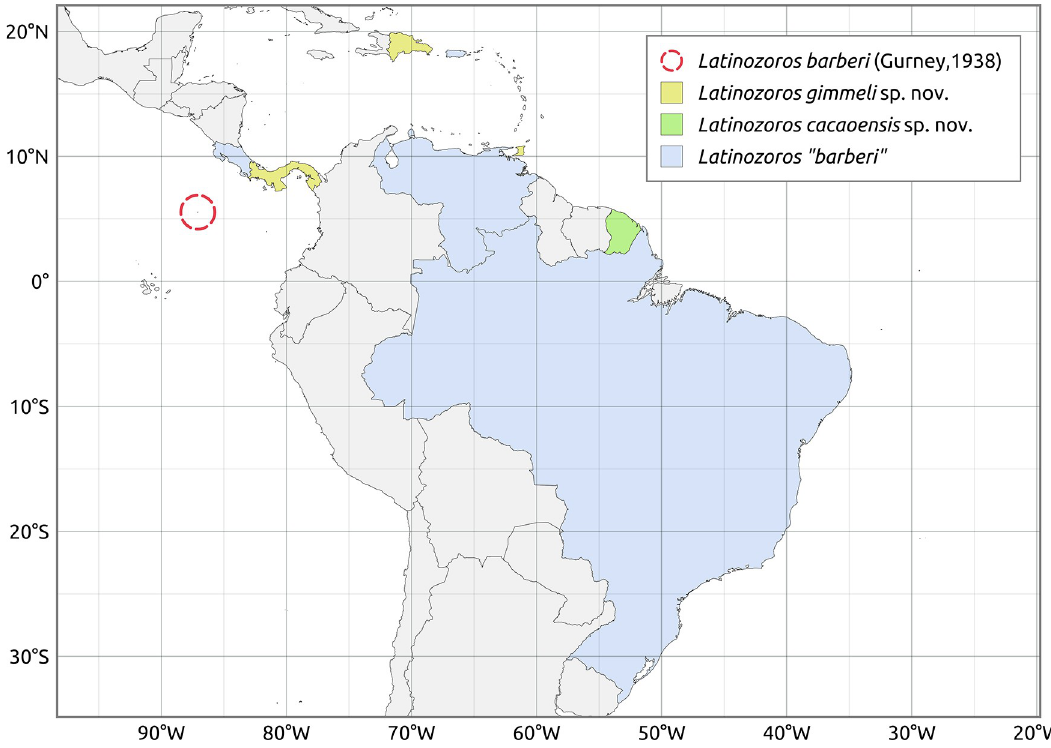
Fig 10. Known distribution of Latinozoros species. The map was created using Natural Earth , free vector and raster maps (https:// www.naturalearthdata.com). For species in quotation marks, see Materials and Methods.